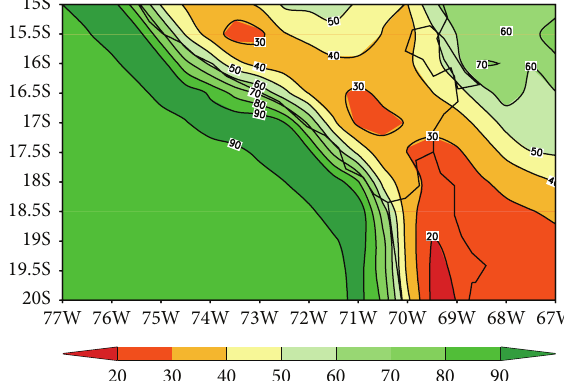
Figure 3: JJA CFS reanalysis climatology 1979–2009 relative humid- ity shaded and contoured (units: